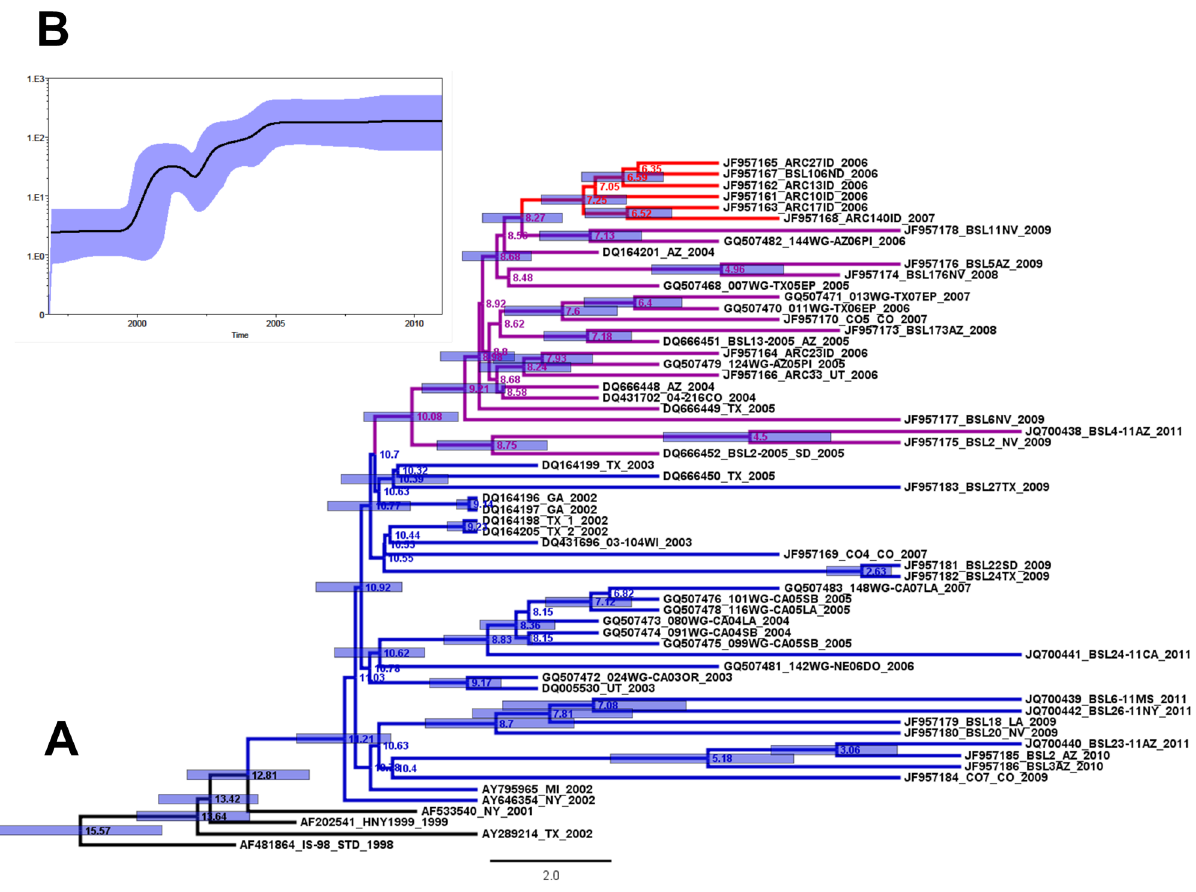
Figure 2. Maximum clade credibility tree from Bayesian analysis of US human-origin WNV strains, 1999–2011. A) WNV genotypes are color-coded in the branches of the tree as NY99 (black), WN02 (blue), SW/WN03 (purple) and cluster MW/WN06 (red). The mean time to the most recent common ancestor ( t MRCA ) is shown in each principal node. The 95% highest probability density (95% HPD) for each node age, are shown as blue bars. B) Bayesian coalescent inference of genetic diversity and population dynamics using the Bayesian Skyline plot available in BEAST 1.6.2., for US WNV of human origin (1999–2011). X axis represents years of study and y axis the relative genetic diversity product of the effective population size. Black line represents the mean estimate and the blue shadow, the 95%